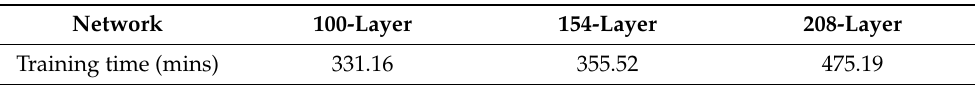
Figure 2. Training accuracy curves for the three networks: ( a ) 100-layer network; ( b ) 154-layer network; ( c ) 208-layer network. Table 2. Training times for the three modified SegNet models with different numbers of